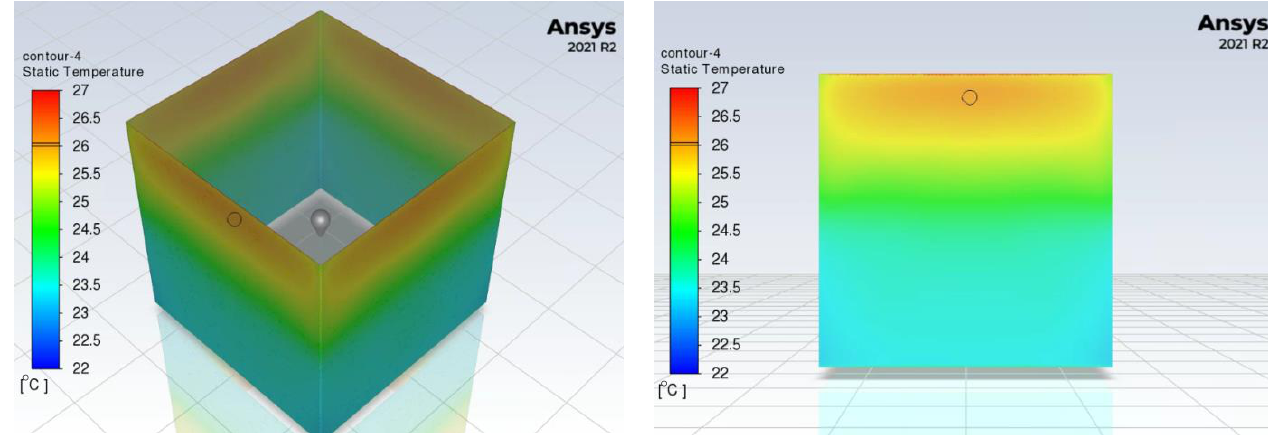
Figure 7. Temperature measurement T 2 and T 4 [ ◦ C] on the side walls of the measuring cube. Designations: (green) external surface temperature T 4 ; (red) inner surface temperature T 2 ; (black) ambient temperature T e . The results obtained with the numerical model are shown in Figures 8–11.